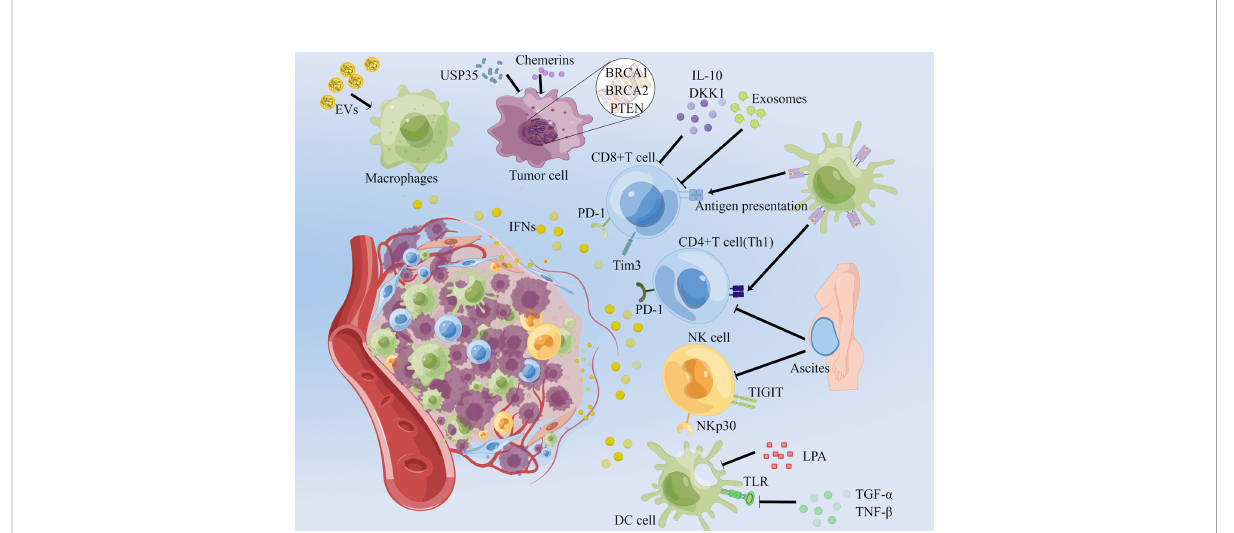
FIGURE 1 Secretion and regulation of IFNs in the OC microenvironment. Normal arrows represent the up-regulators of IFNs secretion, and T-shaped arrows imply barriers. In the OC microenvironment, EVs enriched in nucleic acids stimulate macrophages to secrete IFNs; unstable genes in OC cells result in the secretion of IFNs; PD-1 + Tim3 + tumor-in fi ltrating CD8 + T cells are able to continuously secrete IFN- g ; blocking the PD-1 of CD4 + T, CD8 + T cells and TIGIT of NK cells can reduce IFN- g ; and promoting the activating receptor NKp30 plays the inverse effect. EVs: extracellular vesicles, DKK1: dickkopf-related protein 1, LPA: lysophosphatidic acid. This picture is drawn with the help of